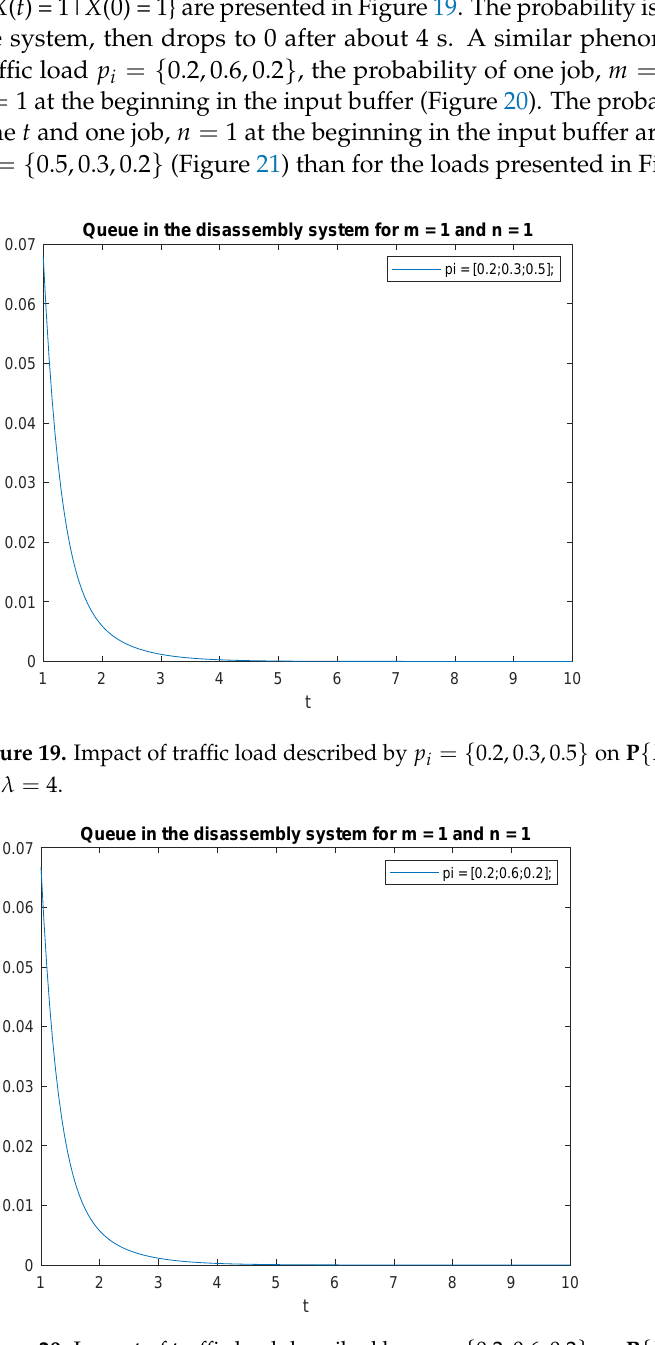
Figure 20. Impact of traffic load described by p i = { 0.2,0.6,0.2 } on P { X ( t ) = m = 1 | X ( 0 ) = n = 1 } for λ =